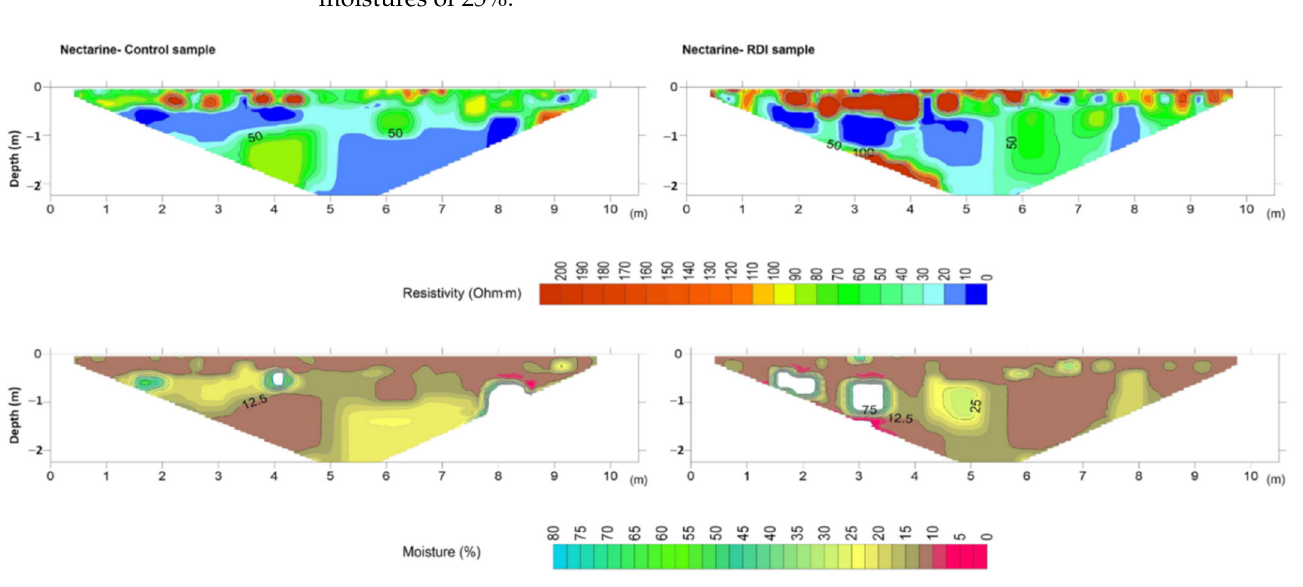
Figure 7. Resistivity model ( top ) and predicted soil moisture ( bottom ) for control ( left ) and deficit irrigation ( right ) in the nectarine orchard.